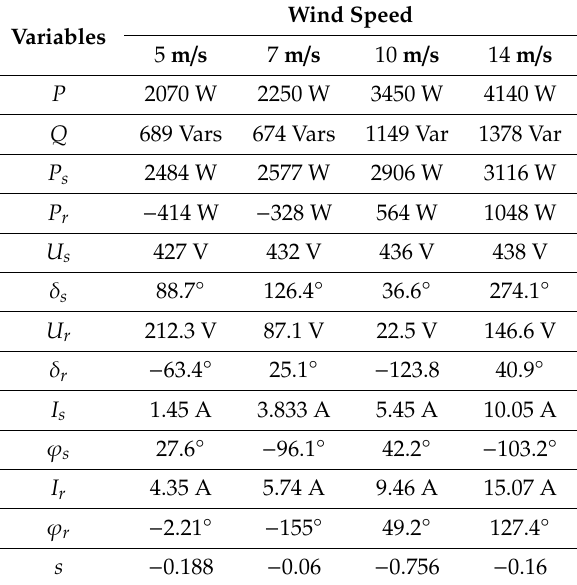
Table 3. Steady-state operating condition of the DFIG with P.F. =